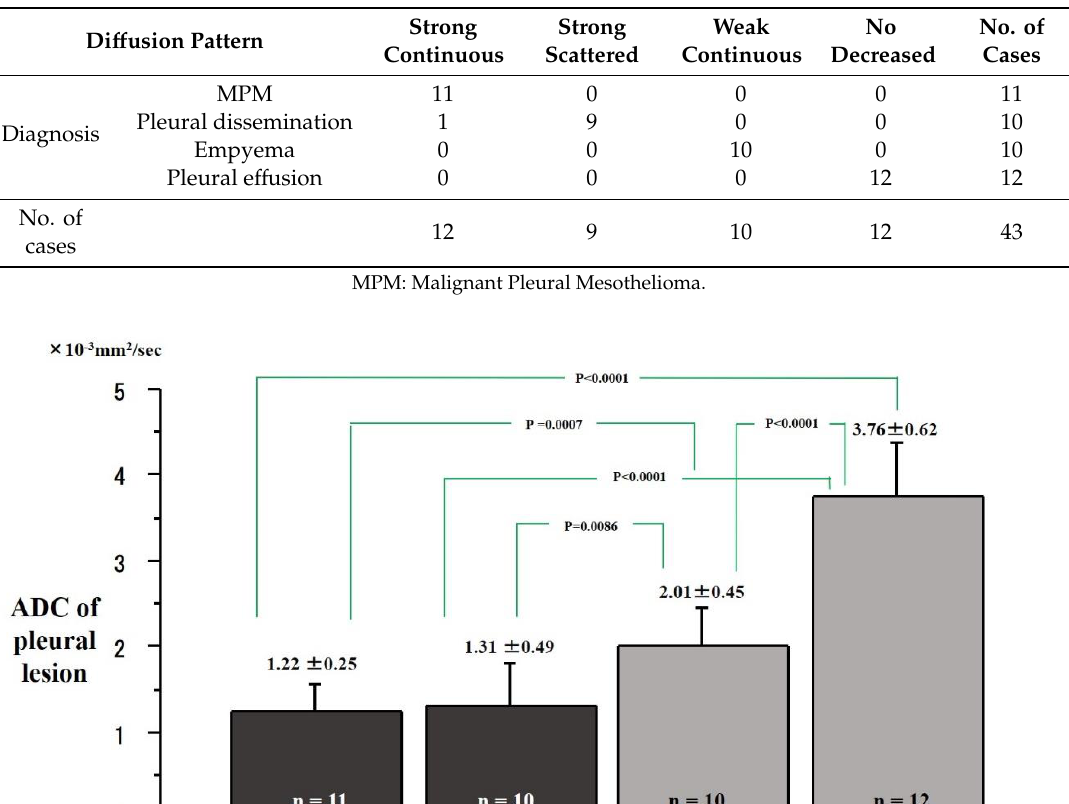
Table 1. Diffusion patterns of DWI for pleural lesions. Table 1. Di ff usion patterns of DWI for pleural lesions.